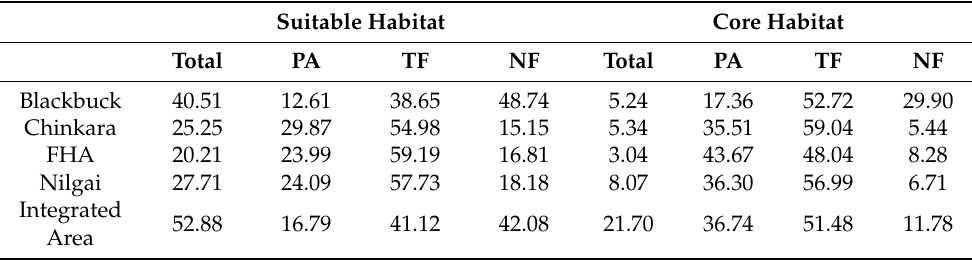
Table 2. Percentage of suitable habitats and core habitats as a function of the total landscape (total) and the allocation of these areas among the three land-use categories, protected areas (PA), territorial forests (TF), and non-forest land (NF).